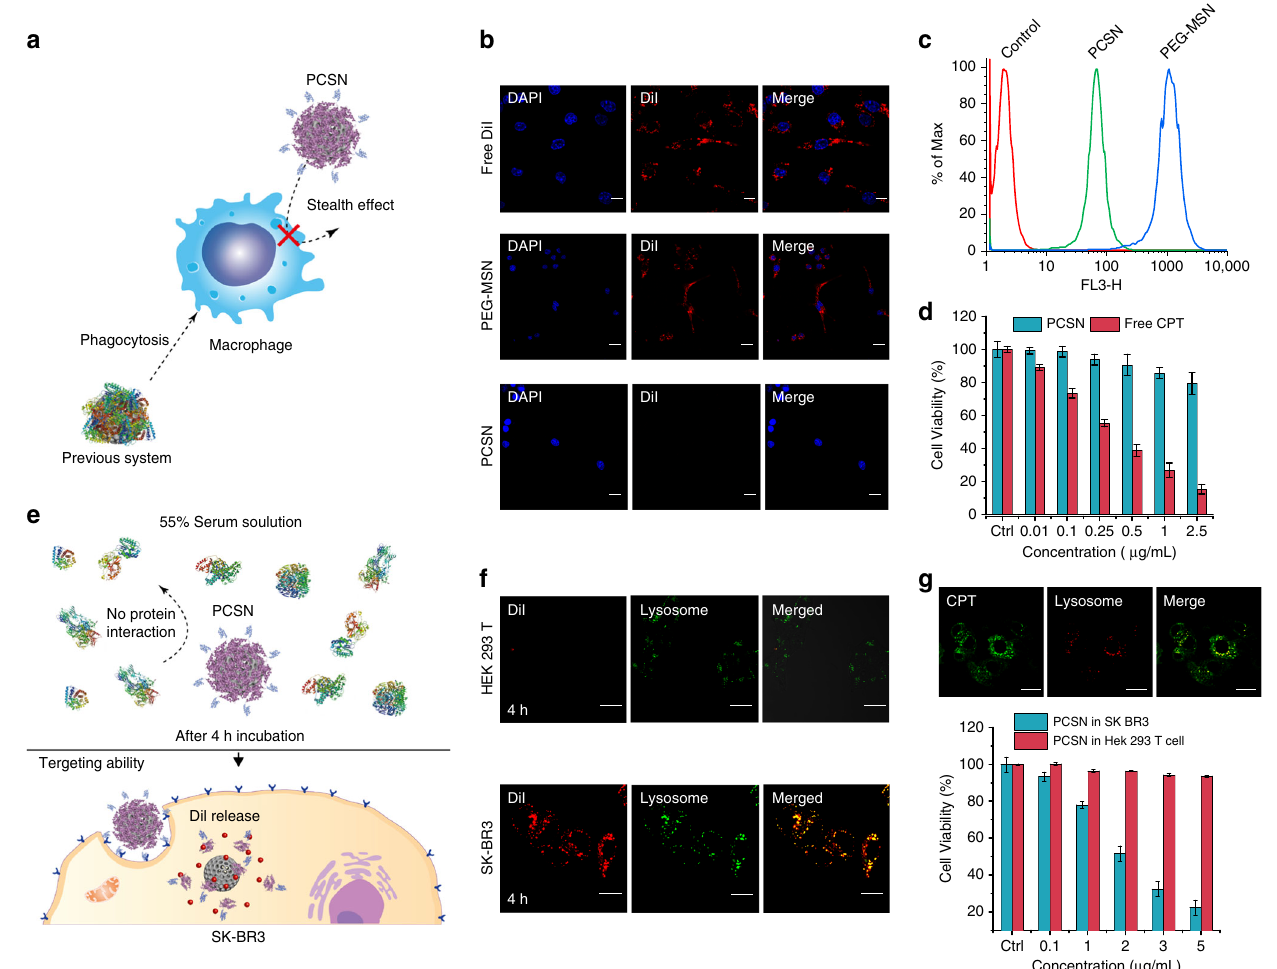
Fig. 3 In vitro experiment and stealth effect of PCSN. a Schematic showing the avoidance of phagocytosis by a macrophage. b Confocal microscopy images of DiI-loaded PCSN and PEG-MSN, and free DiI incubated for 6 h in RAW264.7 cells (scale bar is 20 μ m). c FACS analysis of PCSN and PEG-MSN incubated in RAW264.7 cells for 6 h. d Cell cytotoxicity assay of PCSN and free camptothecin (CPT) on RAW264.7 cells (48 h of incubation). e Schematic of the targeting ability of PCSN treated with 55% serum. Cellular uptake confocal microscopy images of f DiI-loaded PCSN to HEK293T cells (negative control) and to SK-BR3 (target cells). g Cellular uptake confocal microscopic images of camptothecin-loaded PCSN to SK-BR3 and cell cytotoxicity assay (scale bar is 10 μ m). All bar graphs were reported as means ± standard deviations (SDs) for three experimental replicates ( n = fl uorescent intensities between tumors and the reticuloendothelial organs was observed for the PEG-MSN groups (Fig. 4b), indicating that PCS enabled the nanoparticles to evade the immune system and undergo enhanced accumulation in the target tumor. In vivo antitumor ef fi cacy was further evaluated by intravenously administering camptothecin-loaded PCSN (PCSN (CPT)), PEG-MSN (PEG-MSN(CPT)), PCSN, camptothecin (Free-CPT), and phosphate-buffered saline (PBS) to the SK- BR3 tumor-bearing mice. Compared with the PEG-MSN(CPT)- treated group, the PCSN(CPT)-treated group exhibited higher therapeutic ef fi cacy, resulting in ~90.0% inhibition of tumor growth in terms of volume and 2.5-fold enhancement of inhibitory effects (Fig. 4c). Subsequently, by examining tumor weight reduction and histopathology after necropsy on day 22, the PCSN(CPT)-treated group was shown to have enhanced therapeutic ef fi cacy for tumor growth inhibition (Supplementary Fig. 16D, 17). Additionally, hematoxylin and eosin (H&E)-stained lung, liver, spleen, and kidney samples showed no apparent abnormalities or lesions at day 21 after camptothecin-loaded PCSN treatment (Supplementary Fig. 17). These results indicate